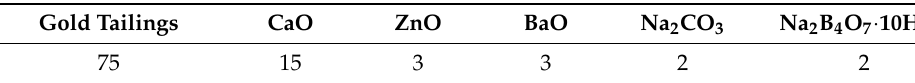
Figure 2. CaO–Al 2 O 3 –SiO 2 glass phase diagram. Figure 2. CaO – Al 2 O 3 – SiO 2 glass phase diagram. Table 3. Composition of glass granules. Table 3. Composition of glass granules.